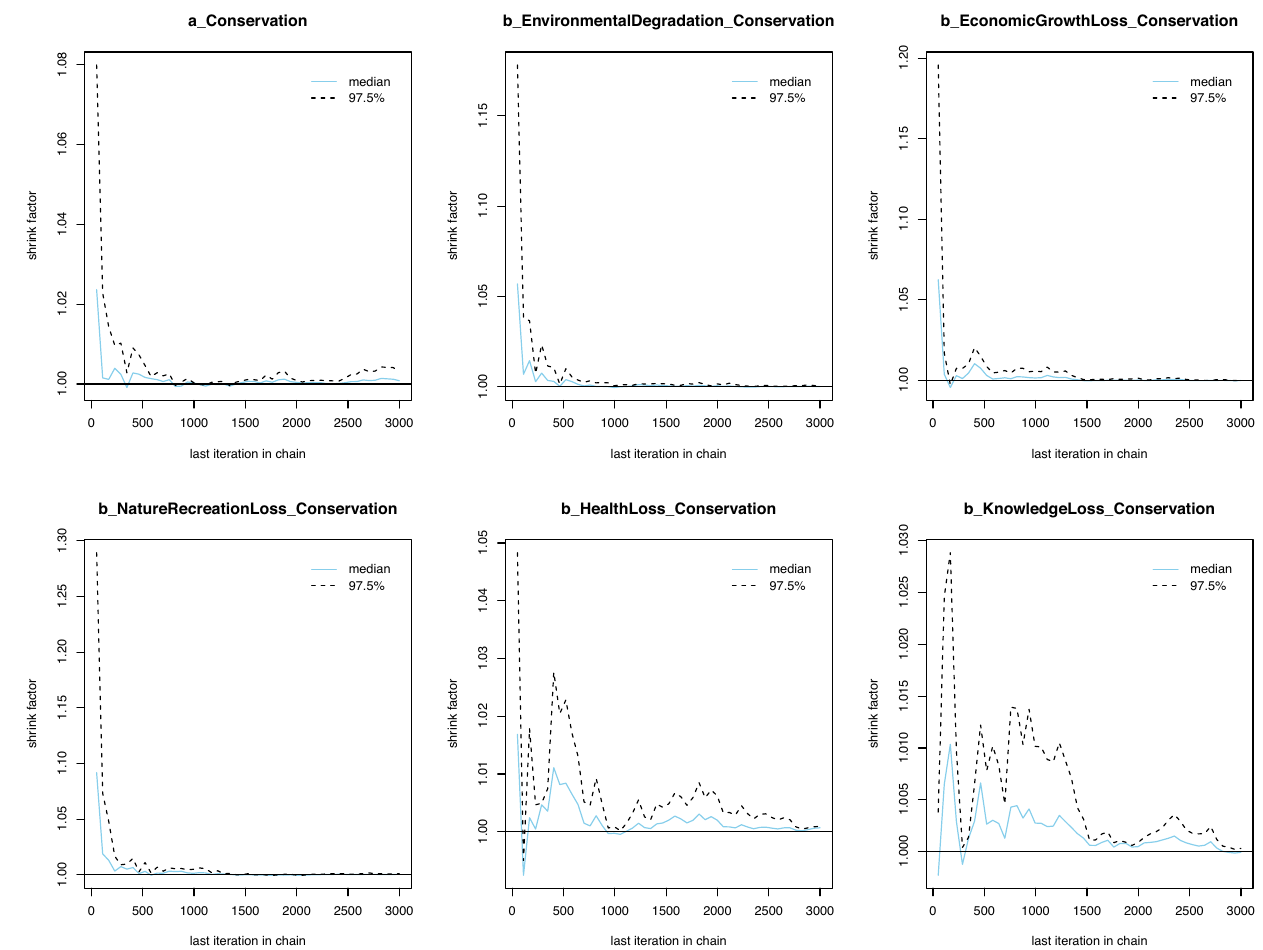
Fig. 4 Model 1 ’ s Gelman – Rubin – Brooks plots with priors as norm (1,0.5). The iterative samples are deemed well-convergent if the Gelman – Rubin shrink factor drops rapidly to 1 before the warmup period completes (or before the 2000 th